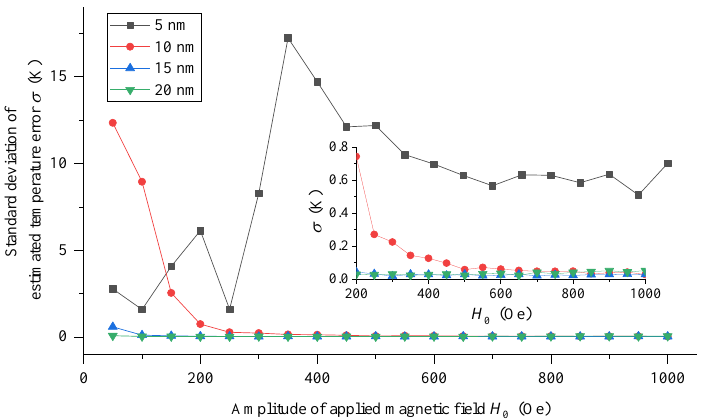
Figure 7. The standard deviation of estimated measurement error of MNPs with different particle sizes with the changing of the amplitude H 0